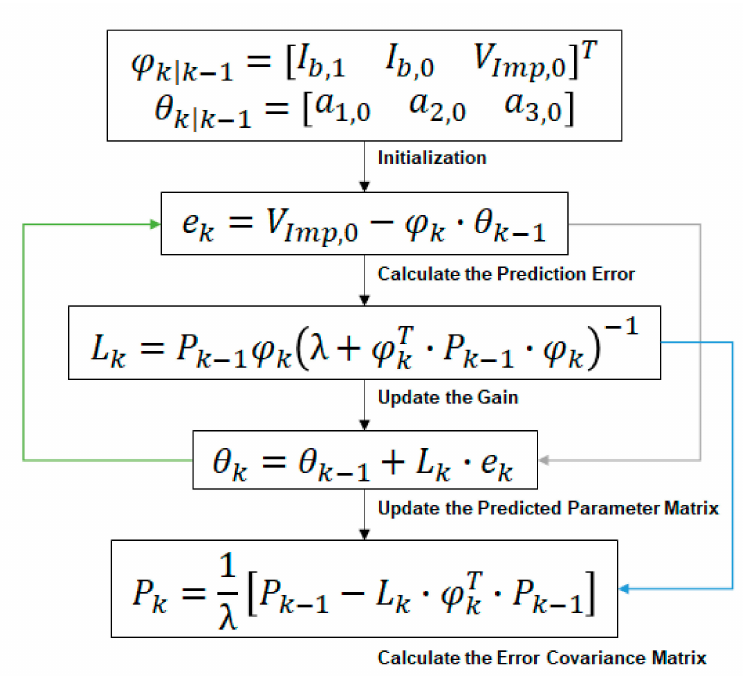
Figure 6. Parameter identification procedure using recursive least square filter and auto regressive exogenous (ARX)